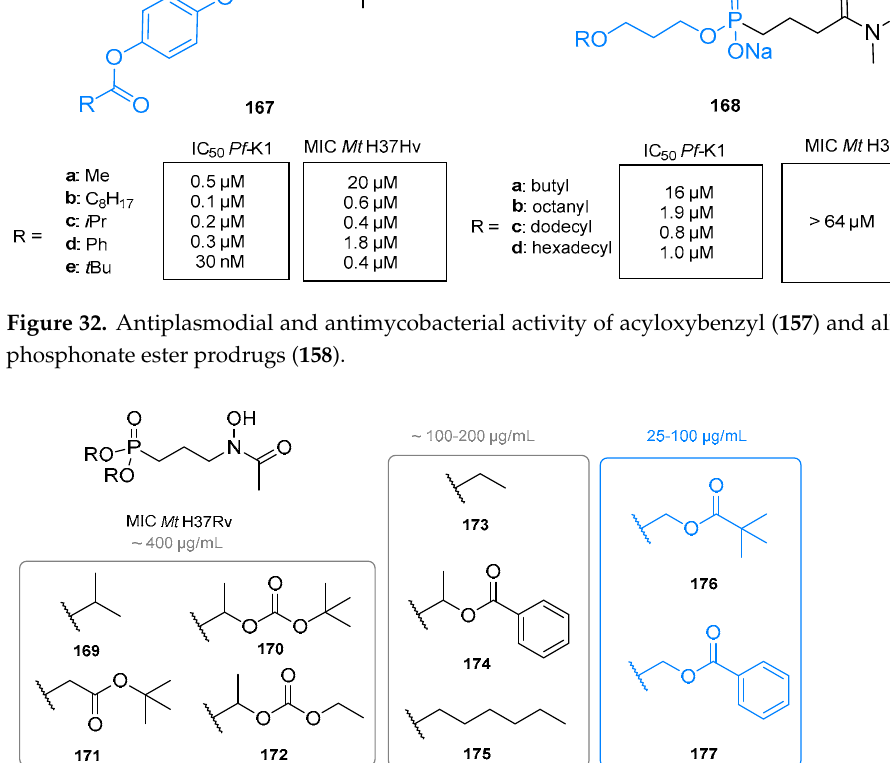
Figure 33. Inhibitory activity of different FR900098 prodrugs ( 169 – 177 ) against M. tuberculosis H37Rv in growth assay. In 2012, Ponaire et al. reported further acyloxymethyl phosphonate prodrugs of 3 and 4 ( 178 – 180 , Figure 34) and tested their activity in an M. smegmatis growth assay using a paper disc diffusion method with a concentration of 400 nmol/disk. (Figure 34) [177]. The phosphonic acids 1 and 2 inhibited the growth of M. smegmatis, whereas the prodrugs